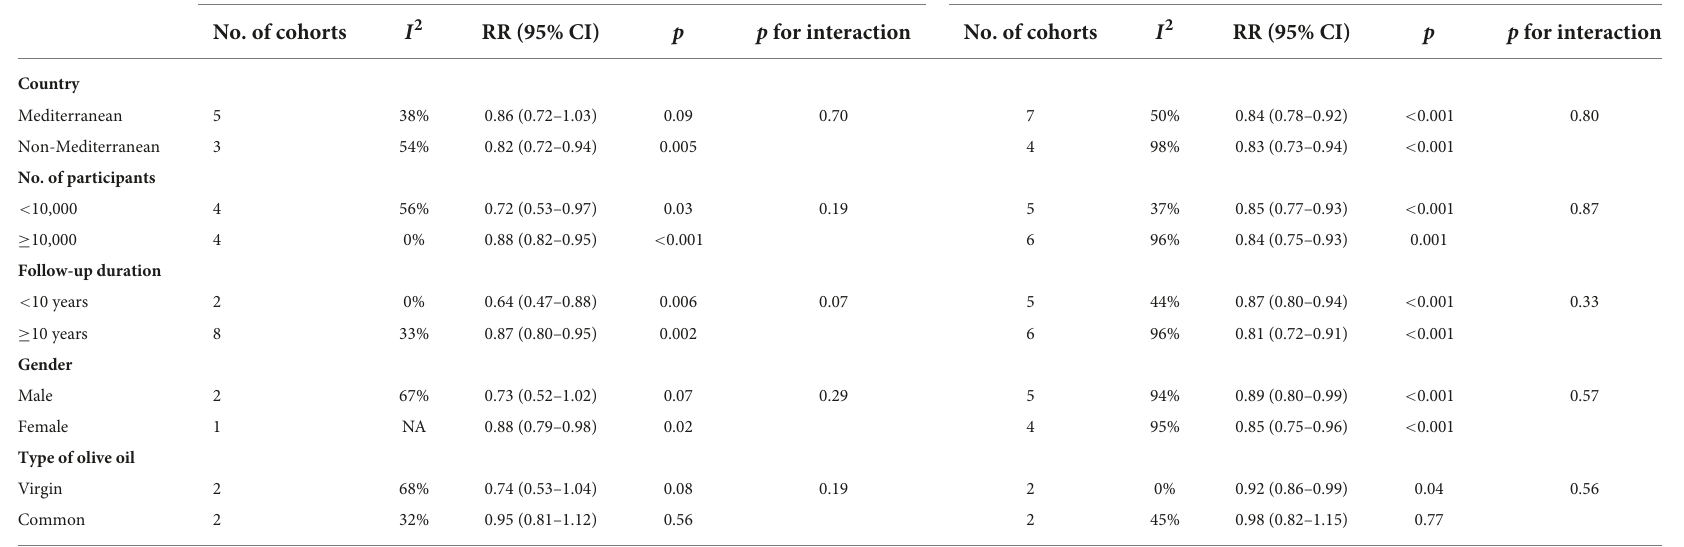
TABLE 2 Subgroup analyses for the risk of cardiovascular disease and all-cause mortality. Subgroup Cardiovascular